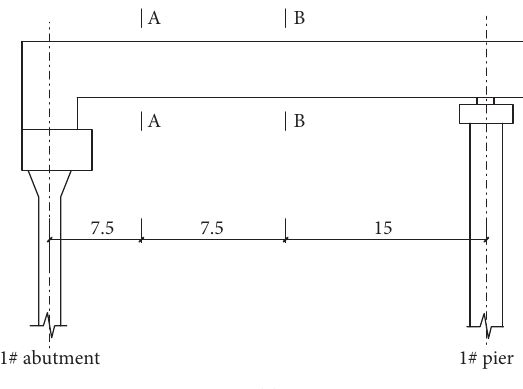
Figure 11: Testing sections.